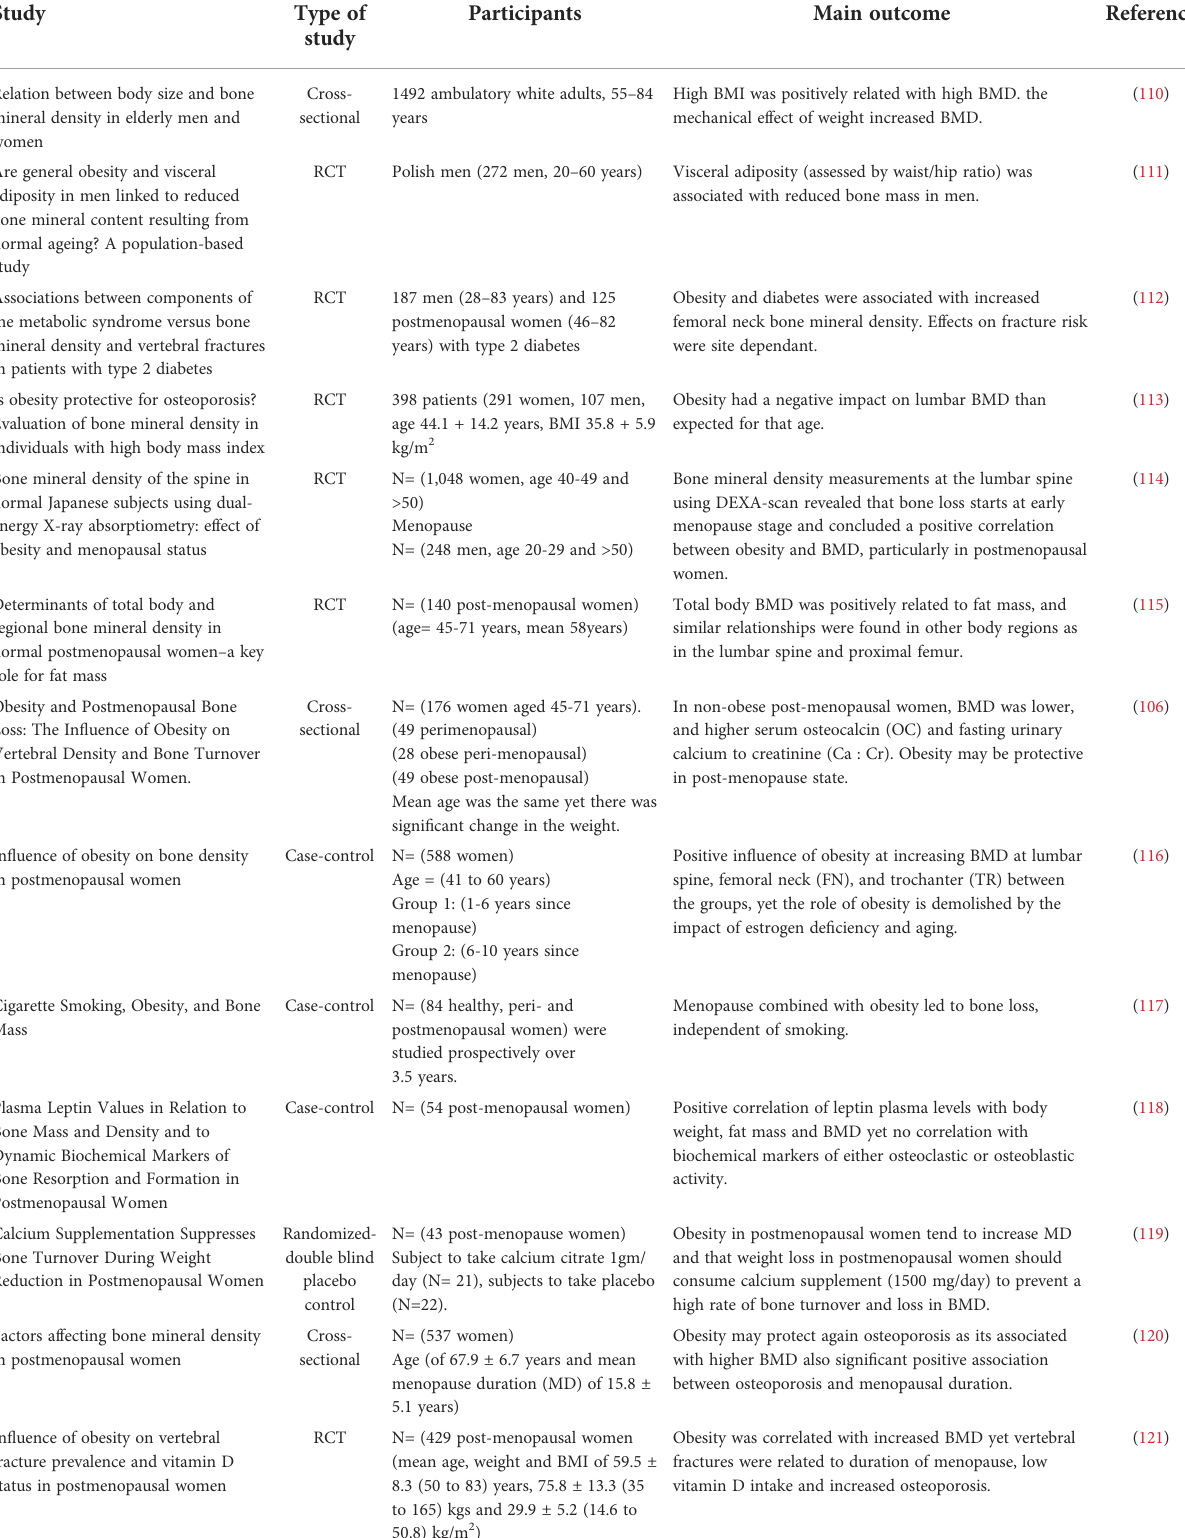
TABLE 2 Clinical studies investigating effect of obesity and diabetes on bone in men &